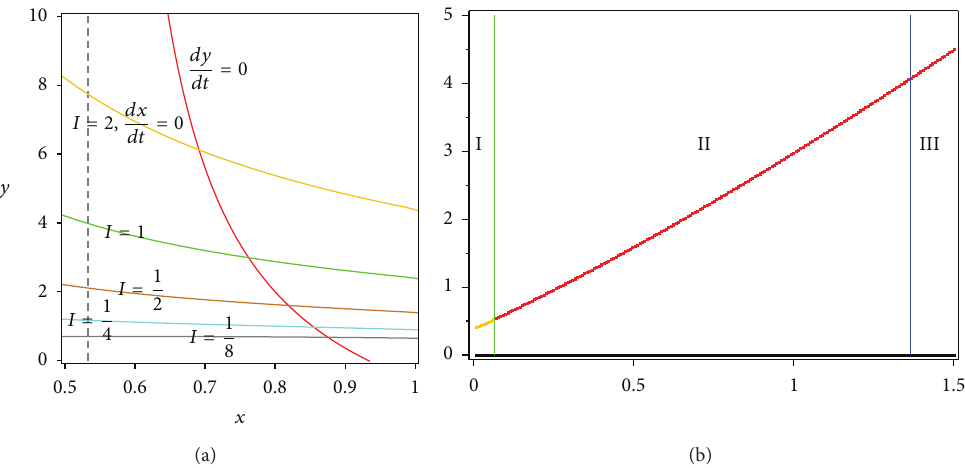
Figure 1: (a) The intersections between the vertical isocline and horizontal isocline with different nutrient concentrations 𝐼 , where the red solid line represents the horizontal isocline, the grey dashed line represents the asymptote of the horizontal isocline, and the other lines with different colors represent the vertical isocline that corresponds to different nutrient concentrations 𝐼 . (b) The stability of the positive equilibrium with the change in the nutrient concentration 𝐼 .